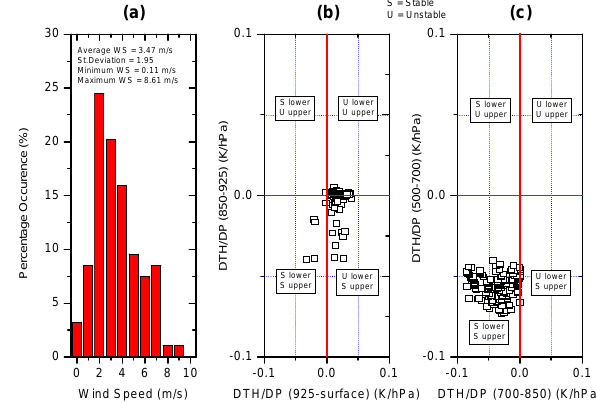
Figure 2 Fig. 2. (a) Frequency distribution of ECMWF wind speed analyses